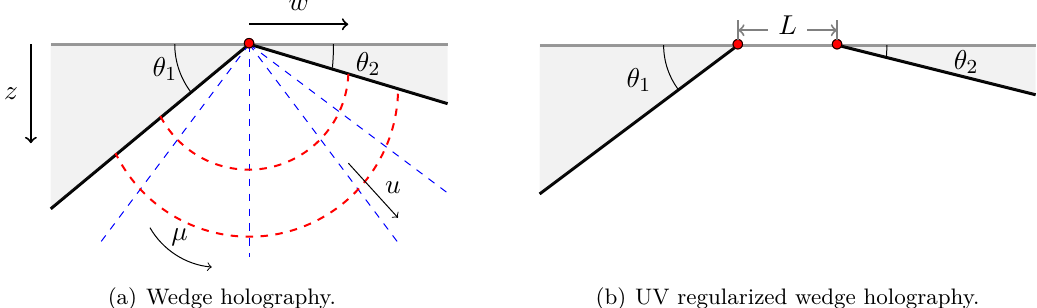
Figure 1 . (a) An illustration of wedge holography: the bulk geometry is a part of empty AdS d +1 between two end-of-world Karch-Randall branes (black lines), meeting each other on the conformal boundary of AdS at their common boundary (the red dot). The bulk shaded regions behind d +1 the branes are removed, leaving only a wedge in the bulk. Wedge holography states that the gravitational physics in the bulk wedge is dual to a ( d − 1) -dimensional conformal field theory living on the red dot (the defect). (b) The wedge holography proposal can be UV regularized by considering a BCFT with two boundaries (the two red dots). By sending the separation L between d the two boundaries to zero, one goes back to the